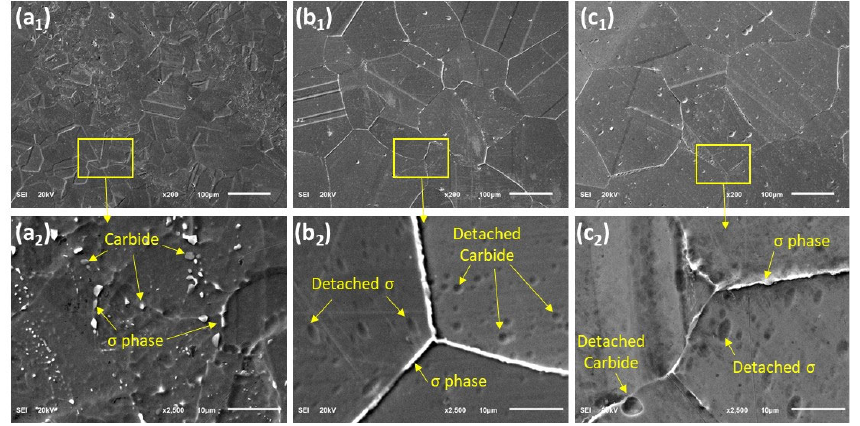
Figure 4. SEM images showing the grains and the grain boundaries for heat ‐ treated samples ( a 1 , a 2 ) T30, ( b 1 , b 2 ) T60, and ( c 1 , c 2 ) T120. Table 2. The elemental composition from EDS analysis of the phases identified in the images in Figure